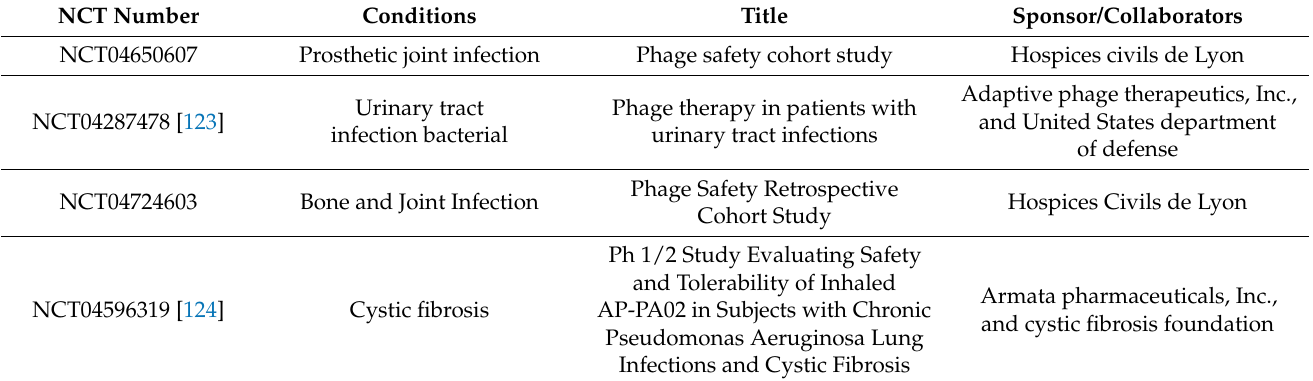
Table 2. Current clinical trials for phage to be used as a therapy or sensor for human diseases. Data obtained from www.clinicaltrials.gov (accessed on 9 March